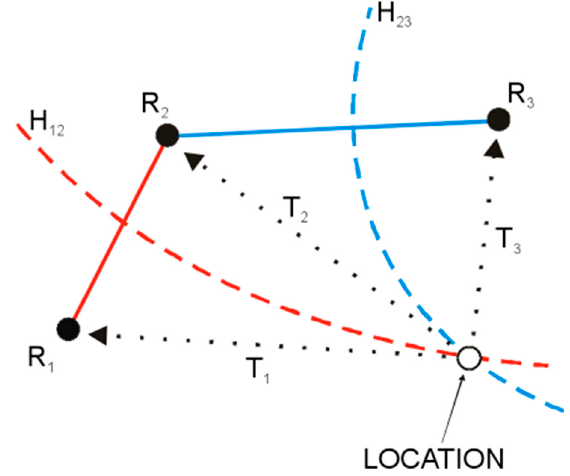
Figure 1. TO A algorithm estimate of the stroke’s coordinates. Figure 1. TOA algorithm estimate of the stroke’s